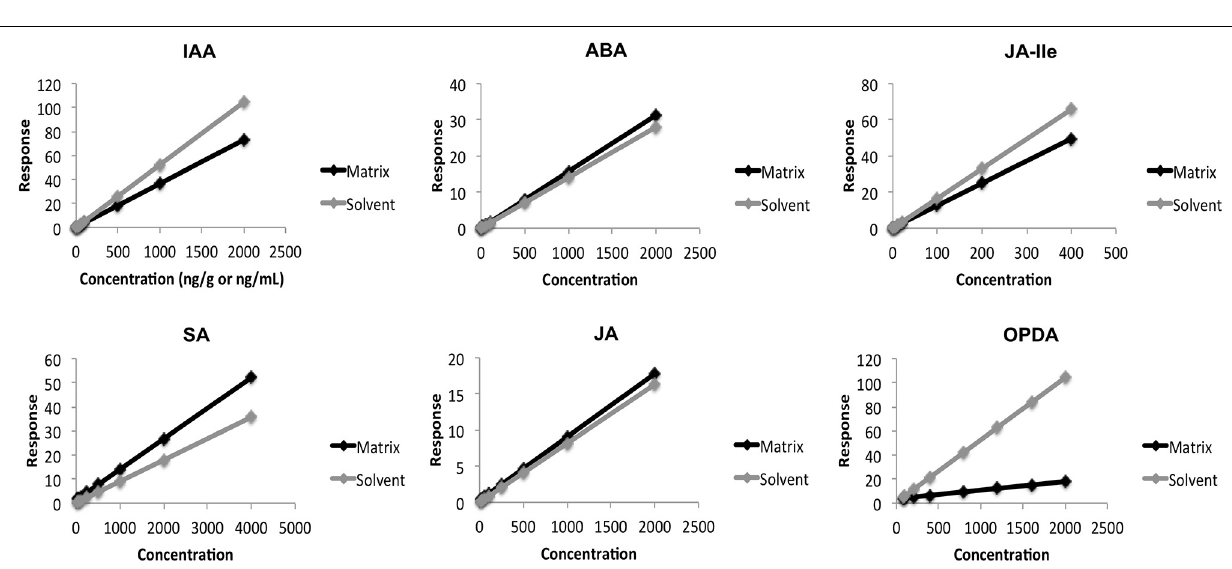
FIGURE 4 | Comparison between calibration curves performed in the matrix ( Arabidopsis thaliana ) and in solvent.